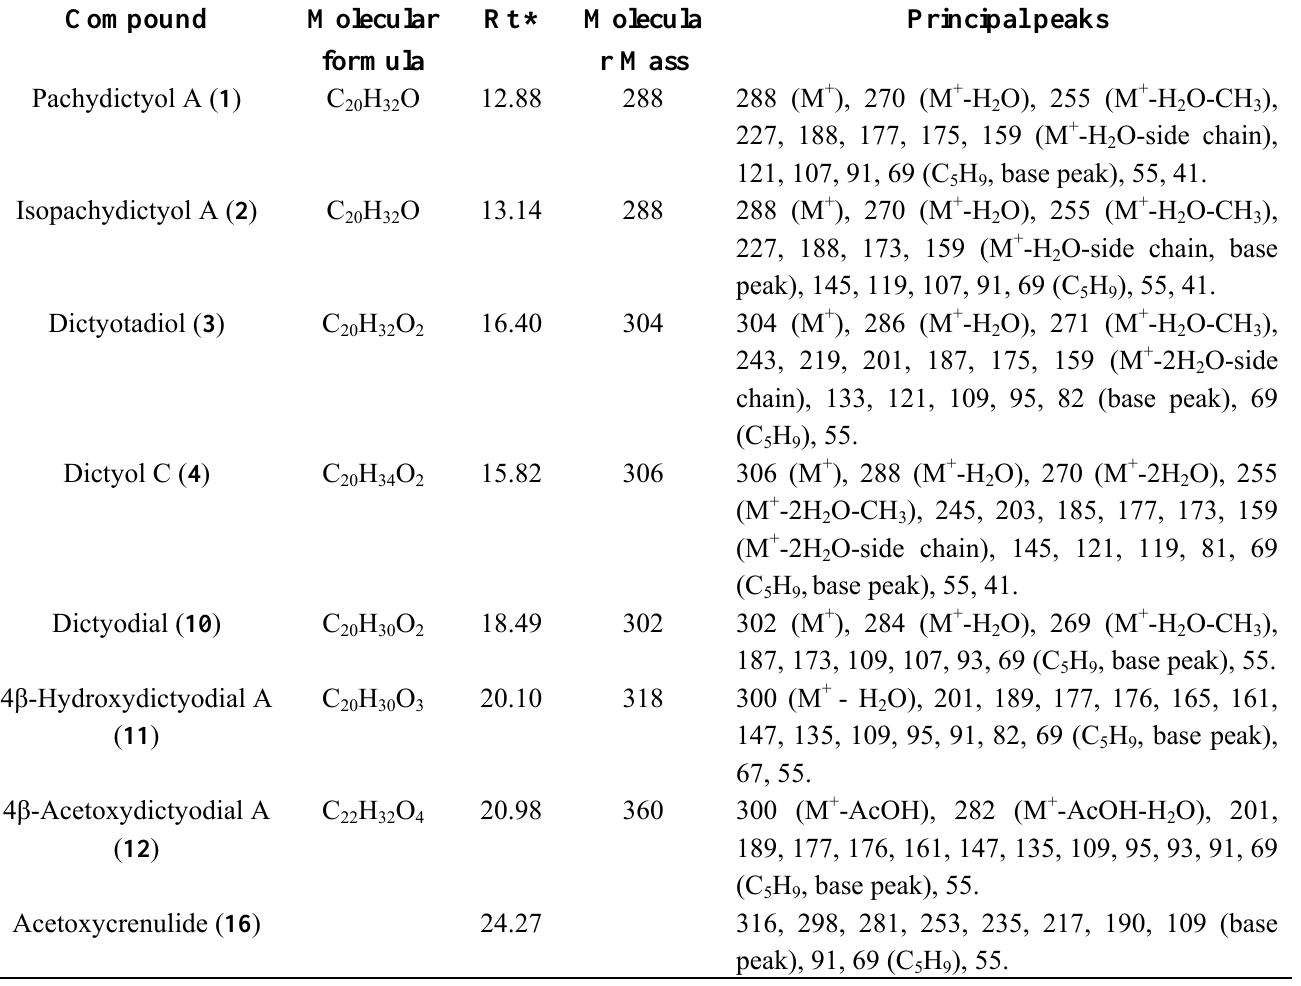
Table 3. Principal peaks observed in the mass spectra ( m/z in parenthesis) of diterpenes from D.